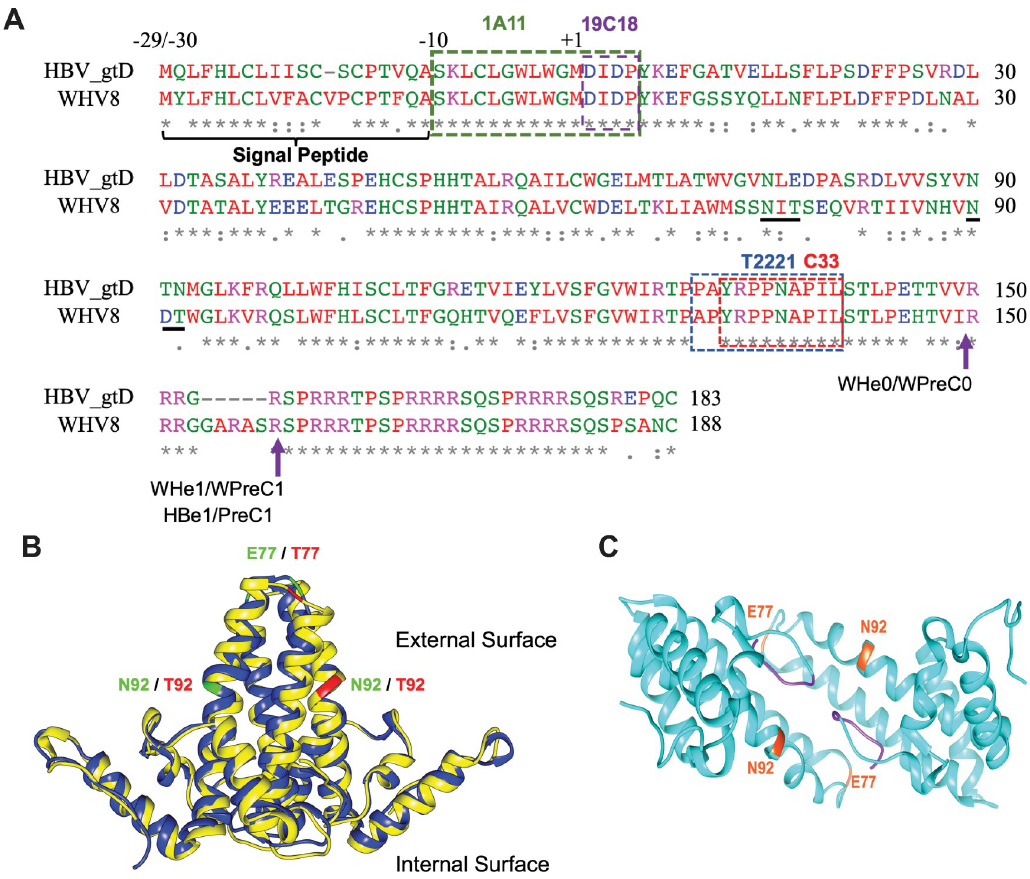
Fig 1. WHV, but not HBV, precore/core gene products are N-glycosylated. (A) Amino acid sequence alignment of HBV (genotype D) and WHV (strain 8) precore/core gene products. The epitopes for mAb 1A11, 19C18, T2221, and C33 are indicated by the dashed boxes. The two putative N-glycosylation sequons 75 NIT 77 and 90 NDT 92 in the WHV precore/core gene are underlined. The arrows indicate the putative cleavage sites in the production of WHeAg (WHe0 and WHe1), WHV PreC protein (WPreC0 and WPreC1), and HBeAg and HBV PreC (HBe1 and PreC1) as identified in a previous study [28]. (B) Alignment of the HBc (Protein Data Bank [PDB] accession code 1QGT, blue) and WHc (PDB accession code 6EDJ, yellow) dimer revealed that the two core proteins share highly structural similarity. The T = 4 icosahedral HBV or WHV capsid contains 120 copies of HBc or WHc dimers. Residues E77 and N92 on HBc (in green) and T77 and T92 on WHc (in red) located on the exterior surface of the capsid, which were mutated reciprocally, are highlighted. (C) Structure of HBeAg (PDB accession code 3V6Z). The N- terminal extensions are labeled in purple, and the two residues, E77 and N92, which are located on the protein surface, are highlighted.